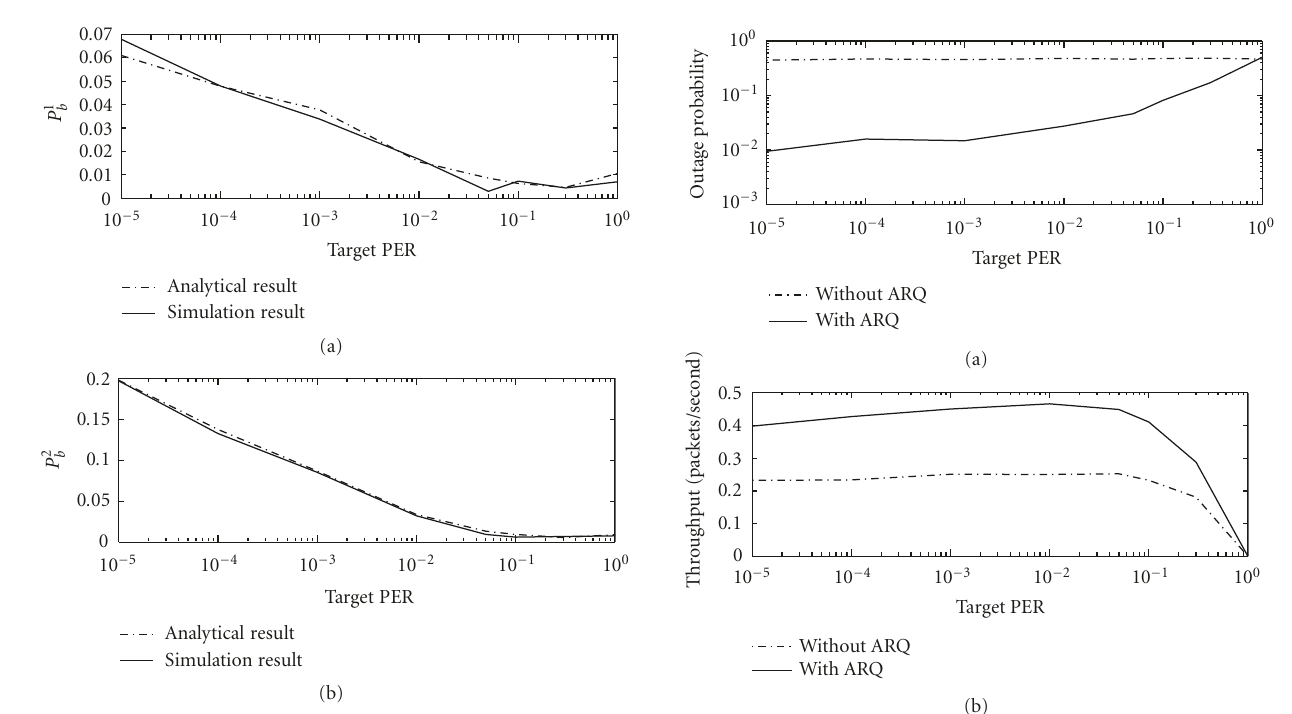
in which L 1 = 0, L 2 = 1, and 2